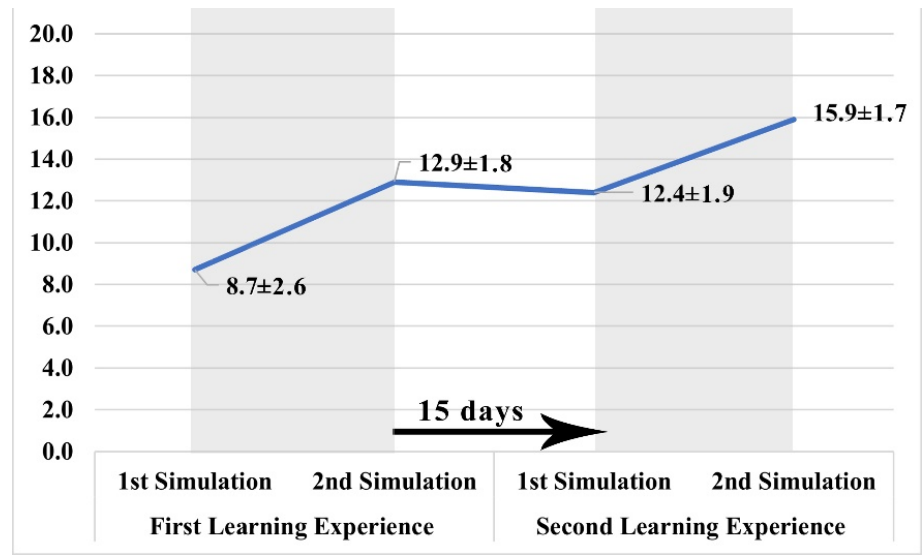
Figure 3. Self-confidence and self-efficacy over time.